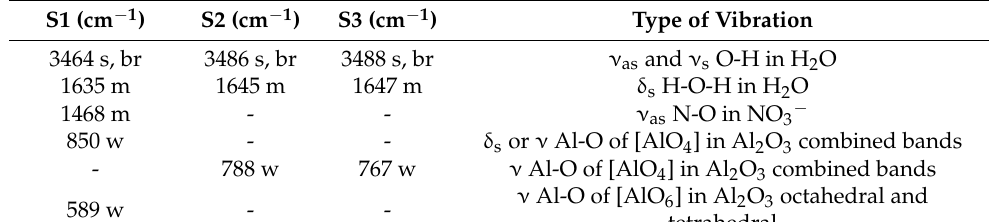
Table 3. Positions and assignments of the bands from FTIR reflectance spectra of samples S1, S2, S3 in 600 ◦ C.